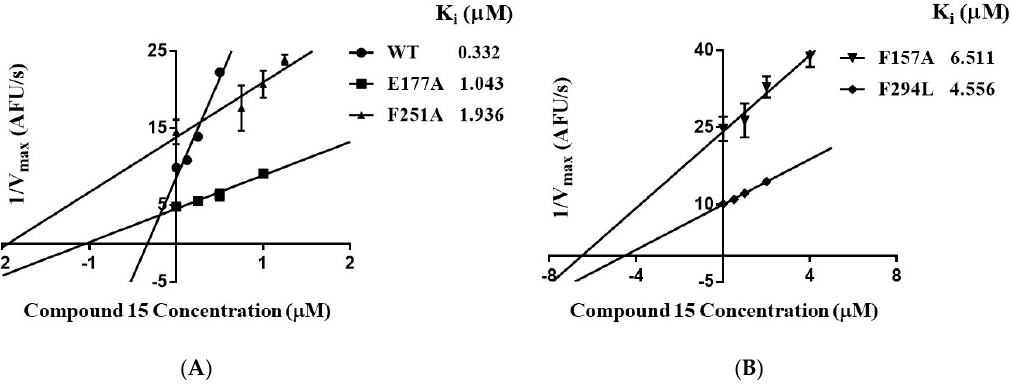
Figure 4. ( A ) K i of compound 15 for wild-type SIRT3 and its mutants (E177A, F251A). ( B ) K i of 15 for SIRT3 mutants (F157A, F294L). K i is the negative of the x-intercept of the plot.